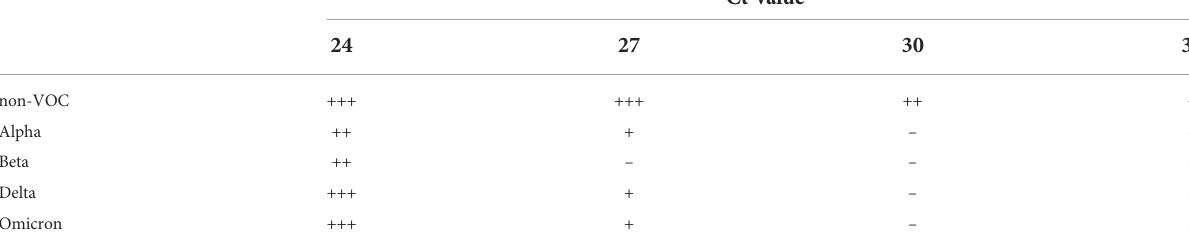
TABLE 3 Detection of SARS-CoV-2 variants by BioNote RAT: VOCs are detected with less sensitivity compared to non-VOC